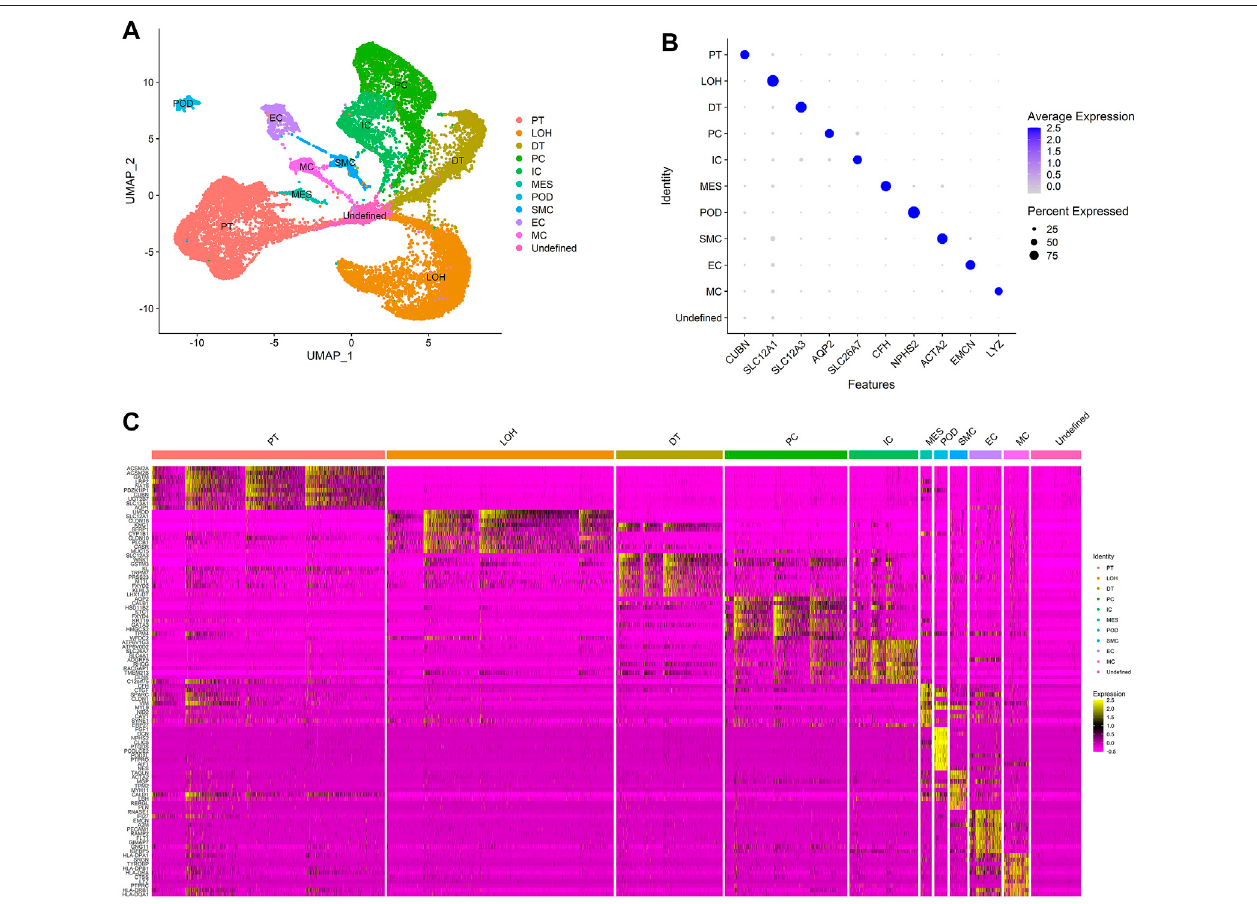
FIGURE 2 | Cell clusters in kidneys of normal control and IgAN delineated by single-cell transcriptomic analysis. (A) UMAP plots of integrated pro fi les of renal cells colored by cell type. PT, proximal tubule; LOH, loop of Henle; DT, distal tubule; PC, principal cells; ICA, intercalated cells; MES, mesangial cells; POD, podocyte; SMC, smoothmusclecells;EC,endothelialcells;MC,macrophages. (B) Dotplotsoftheexpressionlevelofrepresentativemarkergenesacross11cellclusters.Thesizeofthe dot represents the proportion of the cell population that expresses the gene. Shading of color indicates the expression level of the gene. (C) Heatmap of the expression levels of top 10 marker genes in each cell cluster.